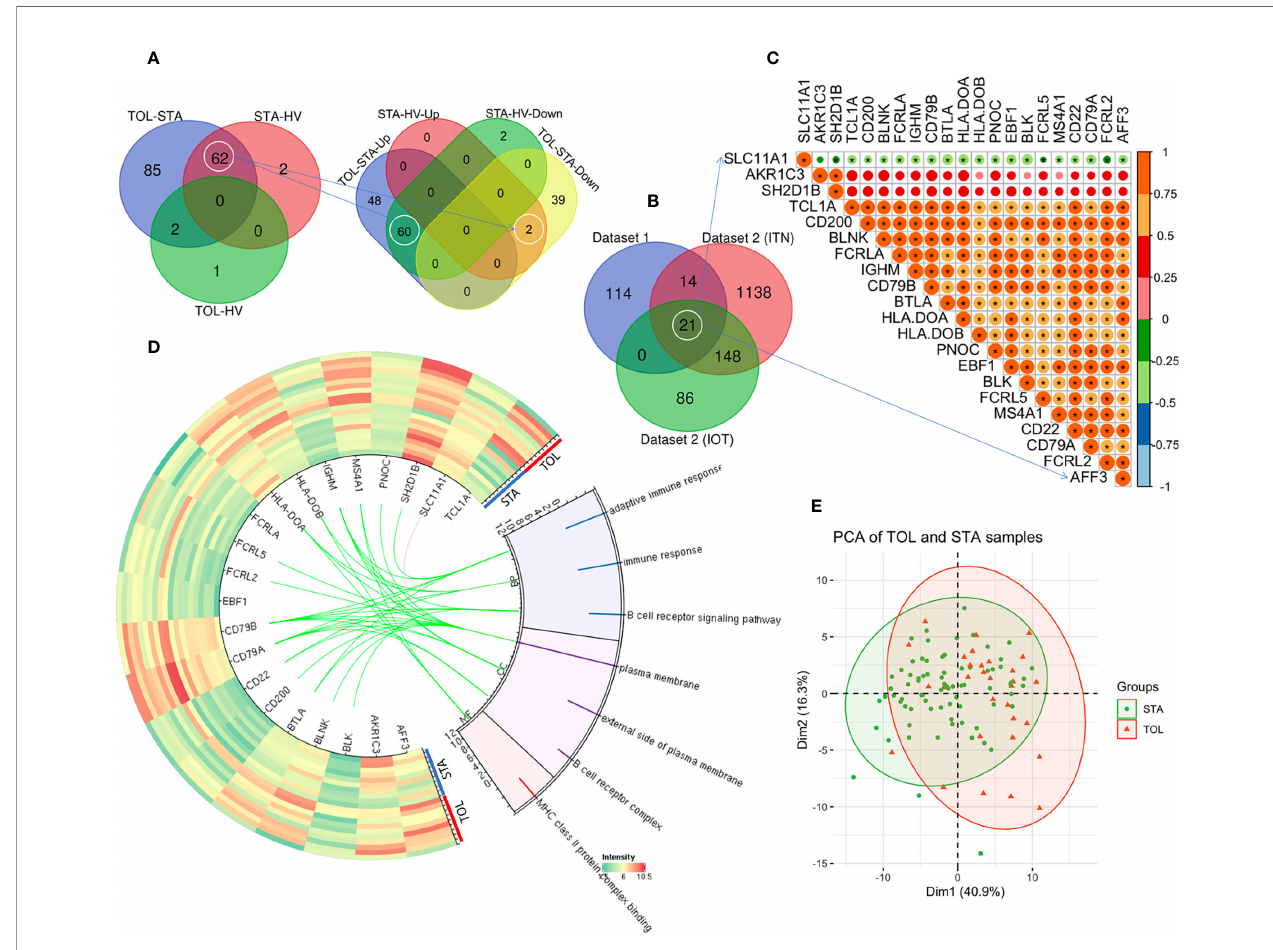
FIGURE 1 | Identi fi cation of differentially expressed genes. (A) Venn diagram of the DEGs in dataset 1 is shown. (B) There were 21 co-DEGs among dataset 1, ITN and IOT in dataset 2. (C) Pearson correlation analysis of the 21 co-DEGs is shown. (D) The heatmap and Gene Ontology (GO) enrichment analysis of the co-DEGs in dataset 1 is demonstrated. (E) The top 2 PCs were used to display the characteristics of STA and TOL. *P <